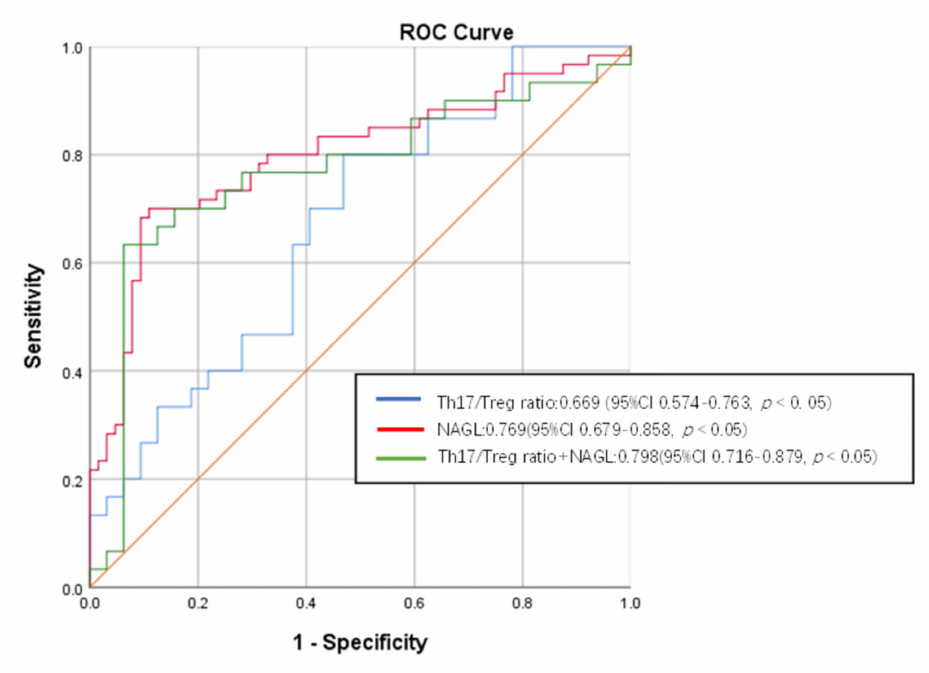
Figure 4. ROC curve of Th17/Treg ratio and NAGL prediction performance for SAKI. SAKI, sepsis- induced acute kidney injury; ROC, receiver operating characteristics; CI, confidence interval; Treg, regulatory T cell; Th17, helper T cell 17; NAGL, neutrophil gelatinase-associated lipocalin. Next, the patients were regrouped by the cutoff value of the Th17/Treg ratio into the high-Th17/Treg-ratio group (Th17/Treg ratio > 0.06967) or low-Th17/Treg-ratio